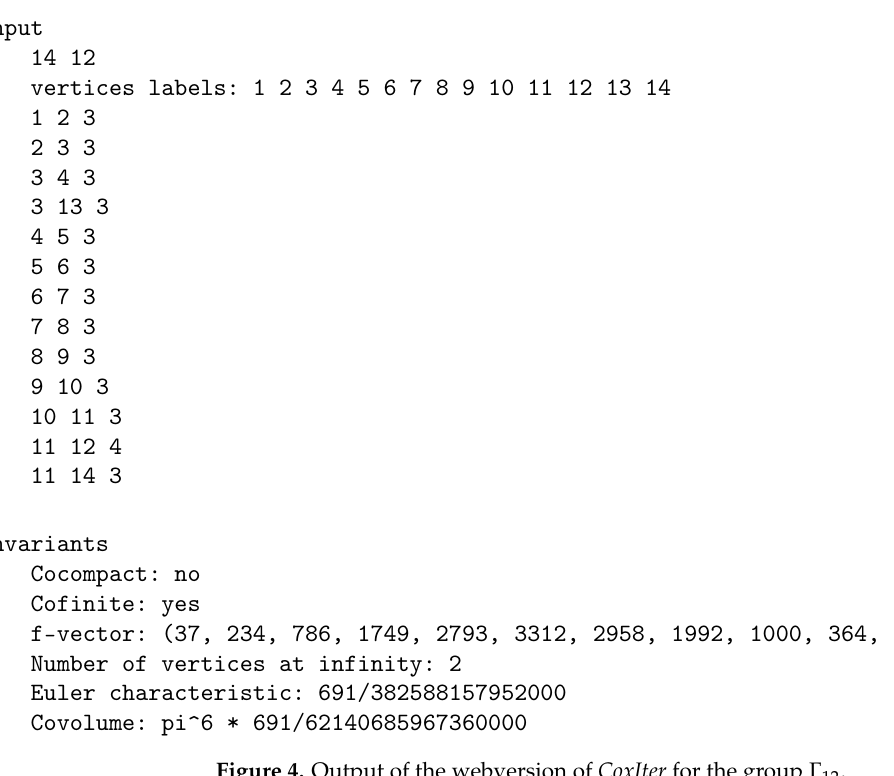
Figure 4. Output of the webversion of CoxIter for the group Γ 12